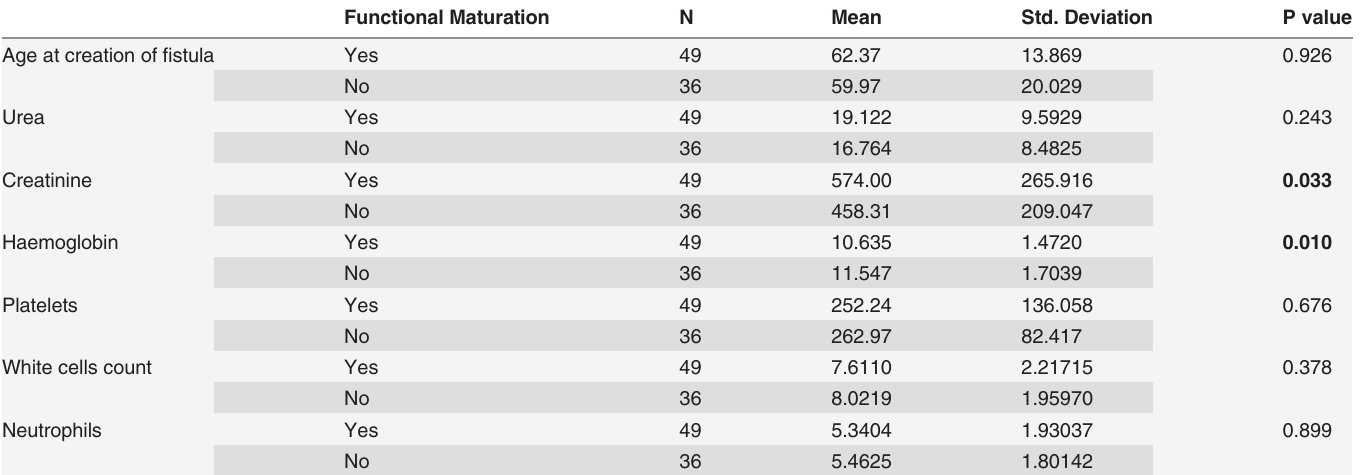
Table 4. Continuous variables (age and blood investigations) association with functional maturation. Functional